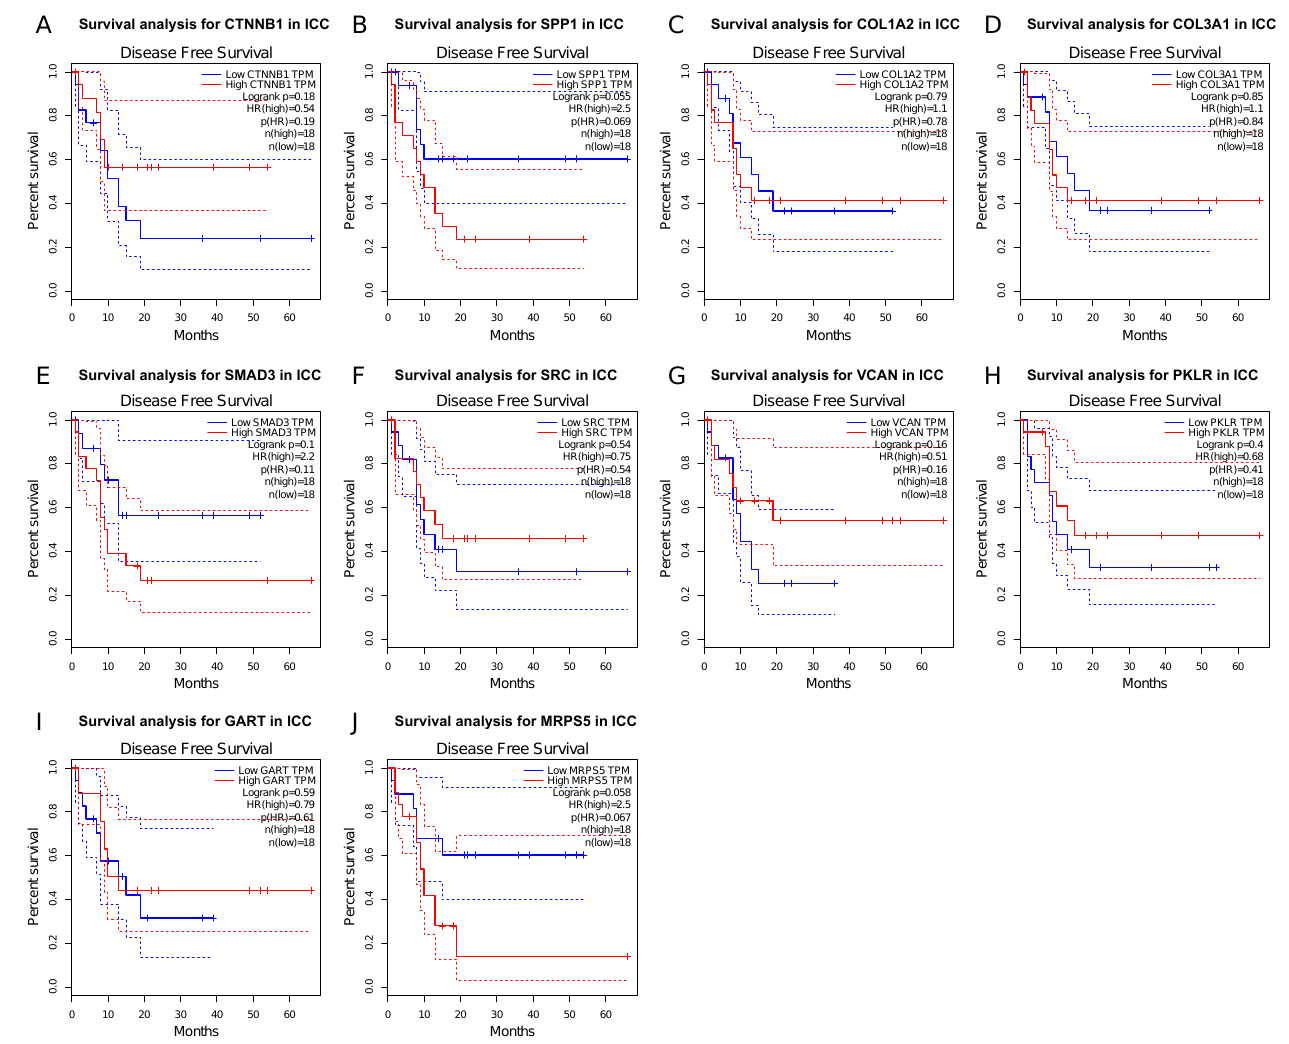
Figure 8. Kaplan–Meier curves of hub gene expression and disease-free survival for each of the top hub genes. Blue curve: low-expression group; red curve: high-expression group.